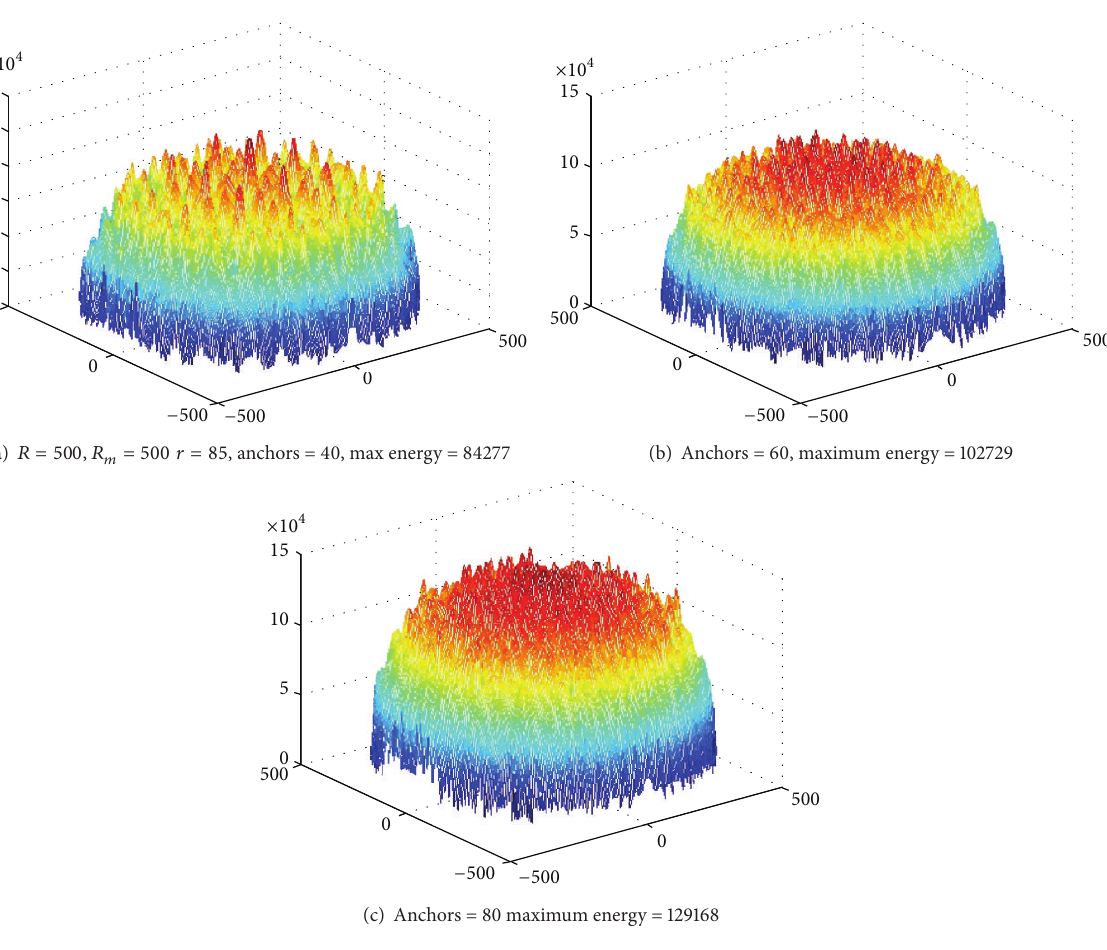
Figure 23: Energy consumption under different numbers of anchor (experimental value).